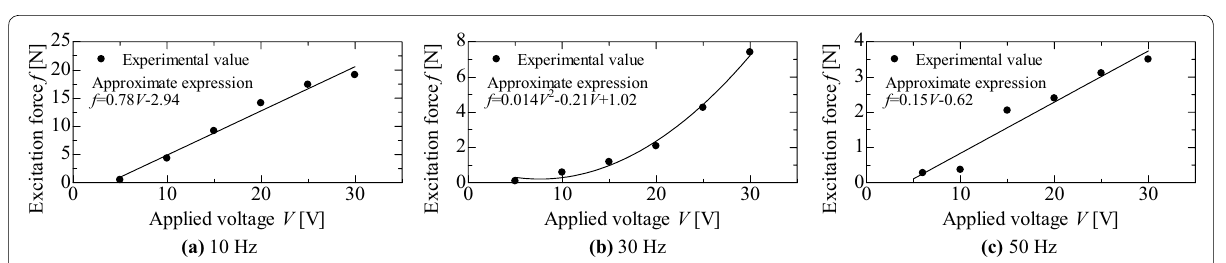
Fig. 8 Relationship between the pushing force and the frequency of the solenoid and their approximate